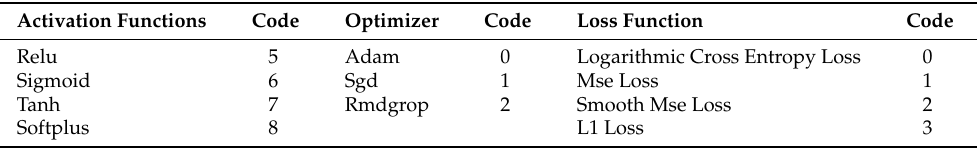
Table 3. Codes of activation function, optimizer and loss